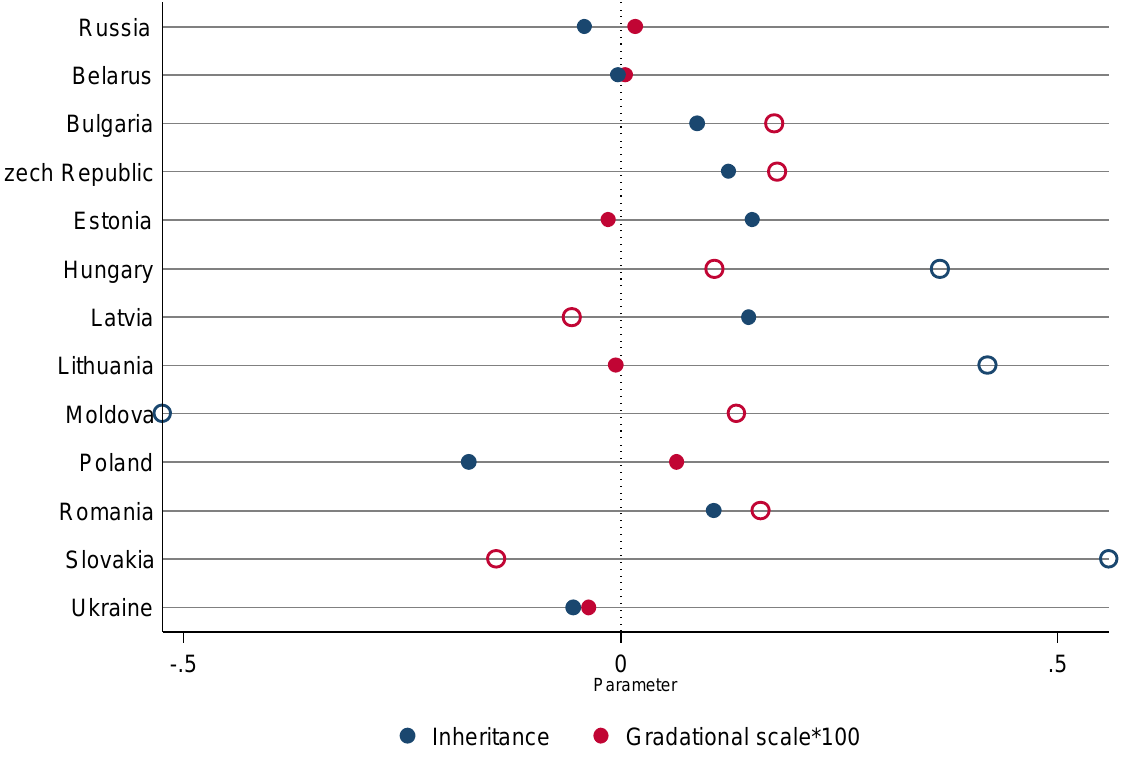
Figure 3: Parameters from model 8 for the differences over time in uniform inheritance and gradational mobility (Russia takes the values of the UI*T and GS*T terms; other countries then plotted using UI*T*C and GS*T*C terms). Hollow circles indicate significant differences from reference category of Russia ( p <